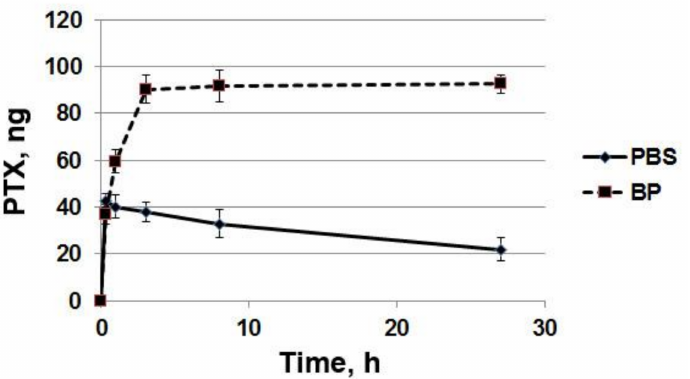
Figure 5. The kinetics of PTX accumulation in the arterial wall. The data are presented as a difference between PTX released from the stent coating and PTX passed through the arterial wall and detected in the surrounding